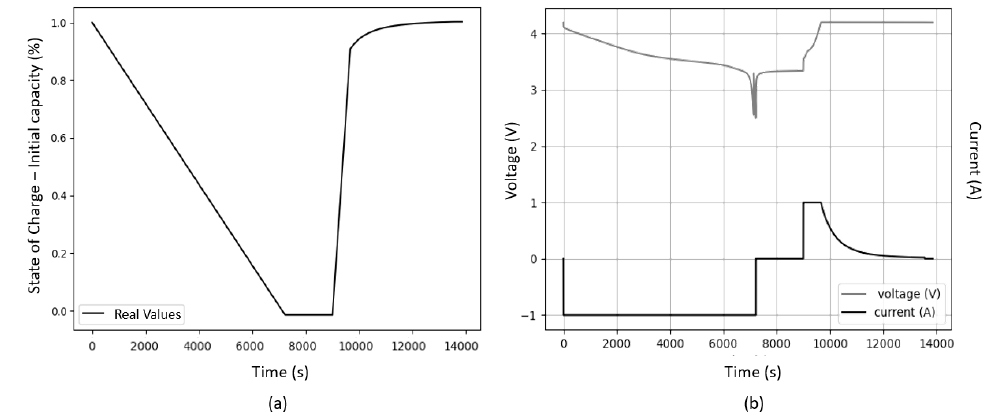
Figure 2. Initial capacity of the battery. ( a ) Battery SoC model. ( b ) Current and voltage profiles for the initial